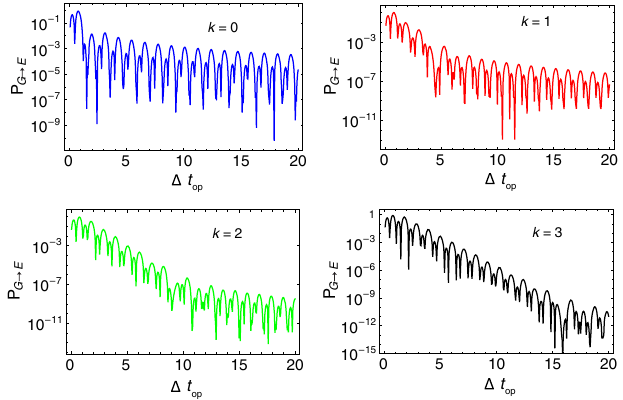
vs braiding period t G → E op